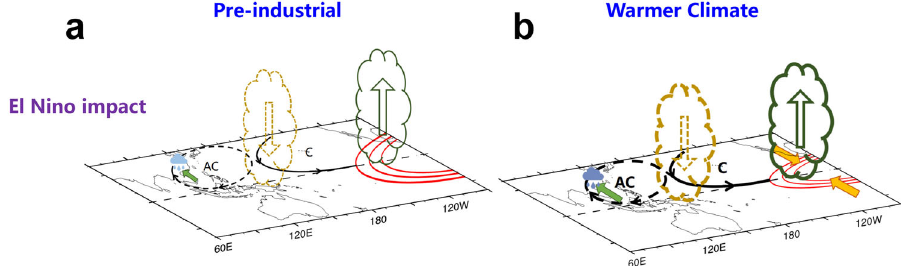
Fig. 3 Schematic diagrams illustrating the changes of El Niño associated with future warming and its effects on the East Asian climate. a El Niño impact on the East Asian climate in the Pre-industrial and b for the warmer climate. AC and C represent anticyclone and cyclone, respectively. This fi gure is adapted from Fig. 5 of Yan et al.